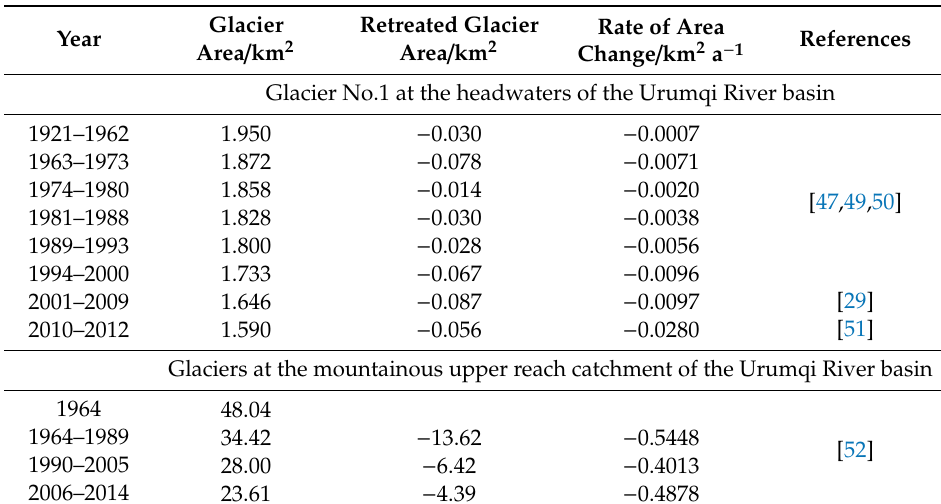
Table 3. Summary of the changes in glaciers in the Urumqi River basin.